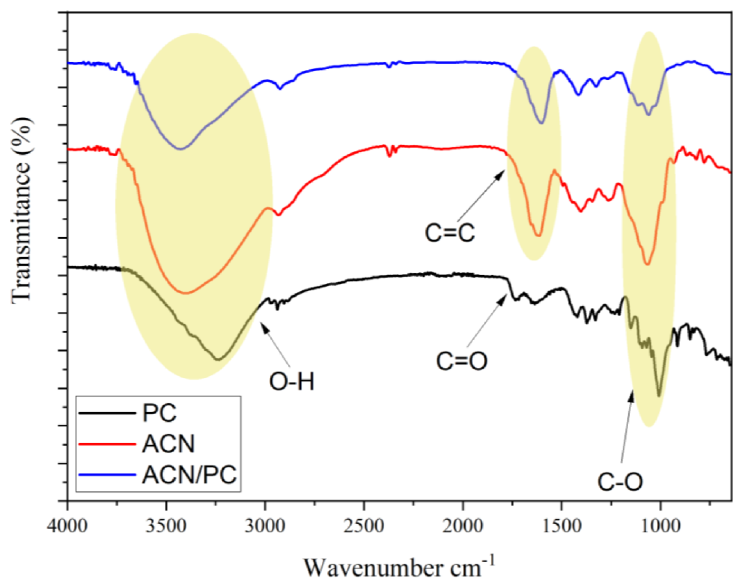
Figure 3. FT-IR spectral profile of PC, ACN, and